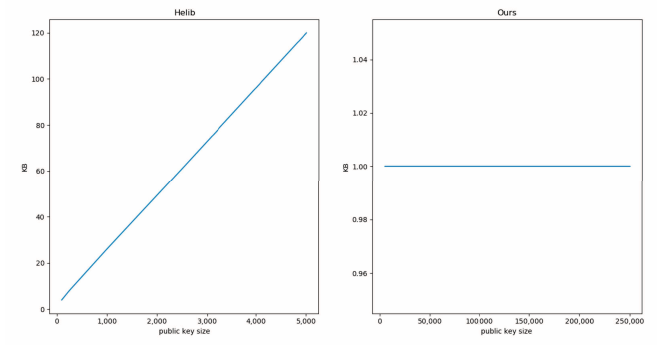
Figure 3. Storage